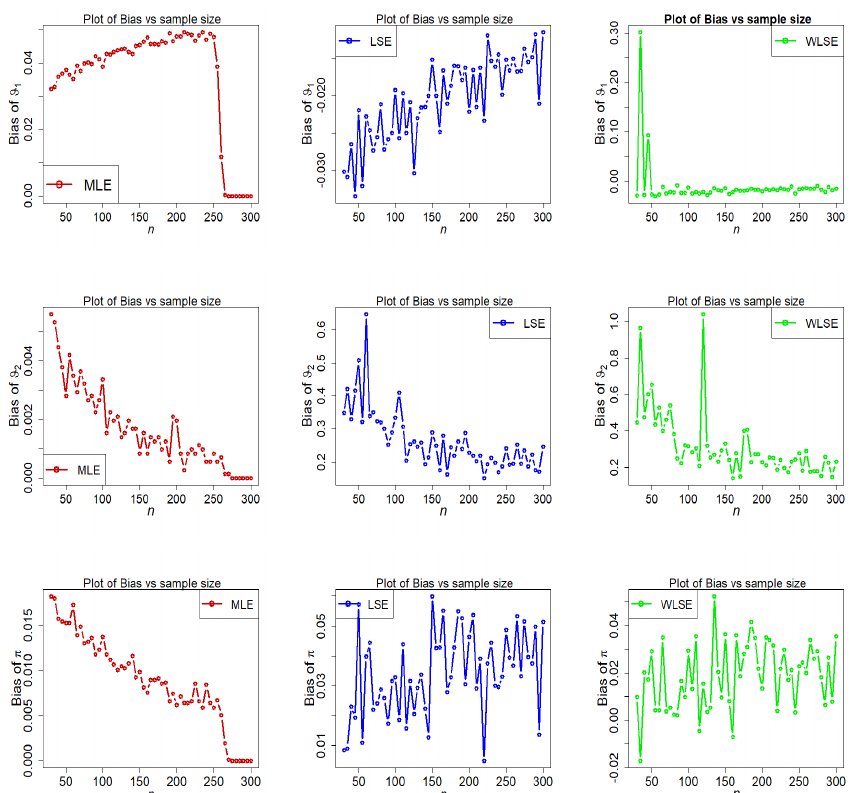
Figure 7. Fluctuations of bias of estimators under different methods for parametric set I.